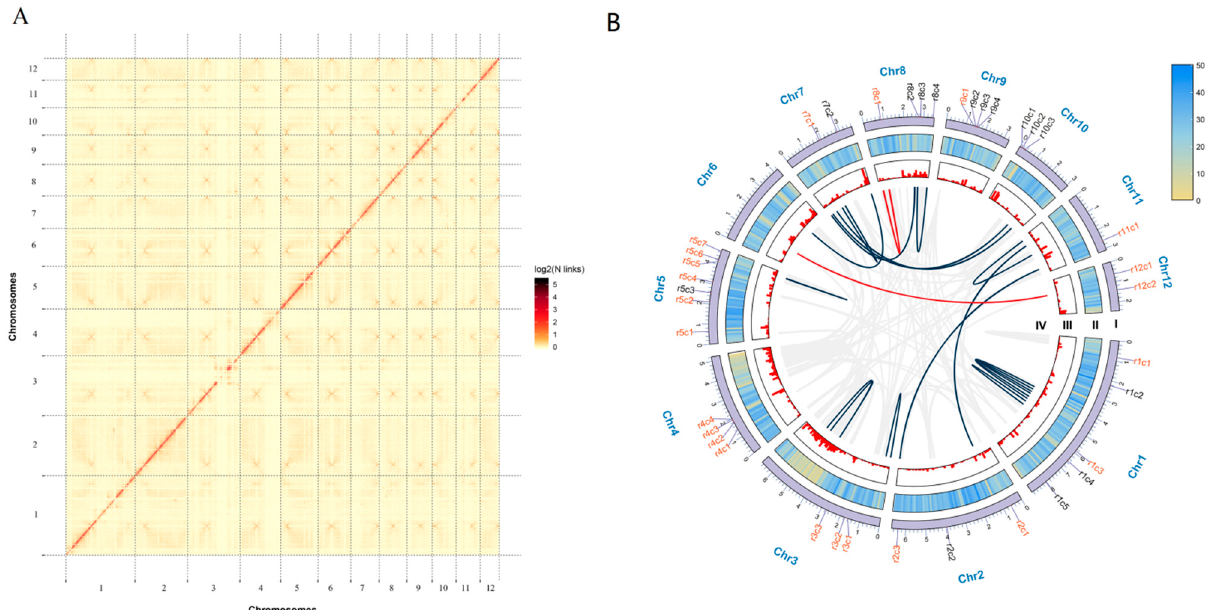
Figure 1. Hi-C interaction heat map and genomic features of the Ganoderma lucidum yw-1-5. ( A ), Hi-C interaction heat map of Ganoderma lucidum yw-1-5 haploid genome. ( B ), Global view of the yw-1-5 genomic features. The names marked outside the circle were identified as gene clusters and the cluster names in red represent the terpene clusters. The detailed information of these gene clusters was listed in Table S6. Circle I represents the 12 pseudo-chromosomes of G. lucidum (Mb). Circle II represents gene density on every pseudo-chromosome. Circle III represents repetitive sequence density on each pseudo-chromosome. Circle IV represents large segmental duplications: regions sharing more than 90% sequence similarity over 10 kb were connected by red lines; those over 5 kb were connected by dark blue lines.